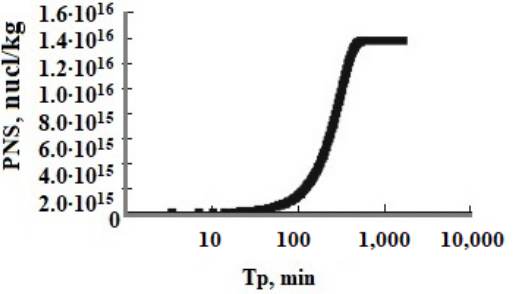
Figure 4. The number of new particles PNS (nucl/kg) versus time Т p; T = 50 °C, the initial concen- tration is C s = 700 mg/kg, рН = 8.